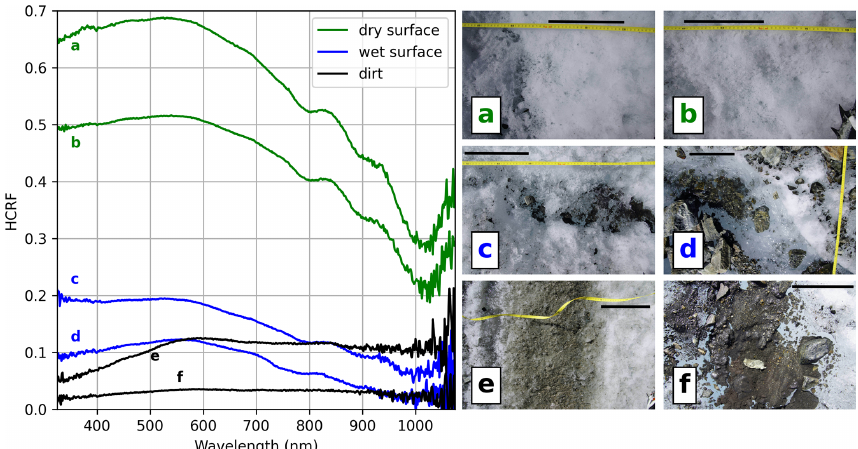
Figure 4. Spectra of different kinds of ice surface types encountered in the ablation zone of Jamtalferner. The photos on the right show the ice surface at the sampling sites of the respective spectra. The black bar in each photo represents approximately 20cm, to provide a sense of scale. The spectra shown in this figure are part of the following profile lines: (a–c) p3, (d) p4, (e) p6, and (f) p12.